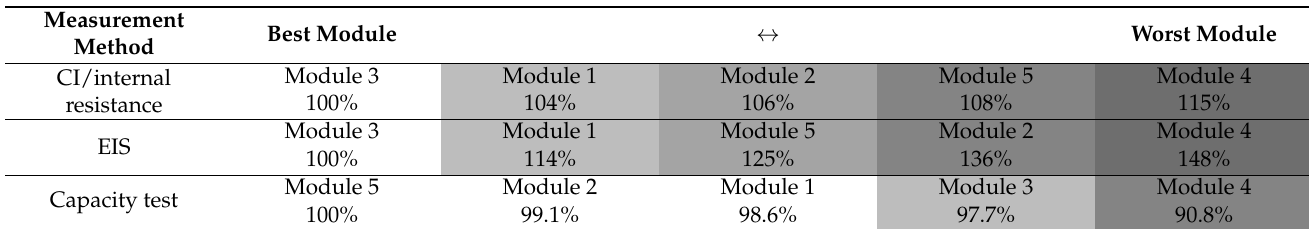
Table 6. Comparison of the measurement methods. Shading represents the order of the aged modules.